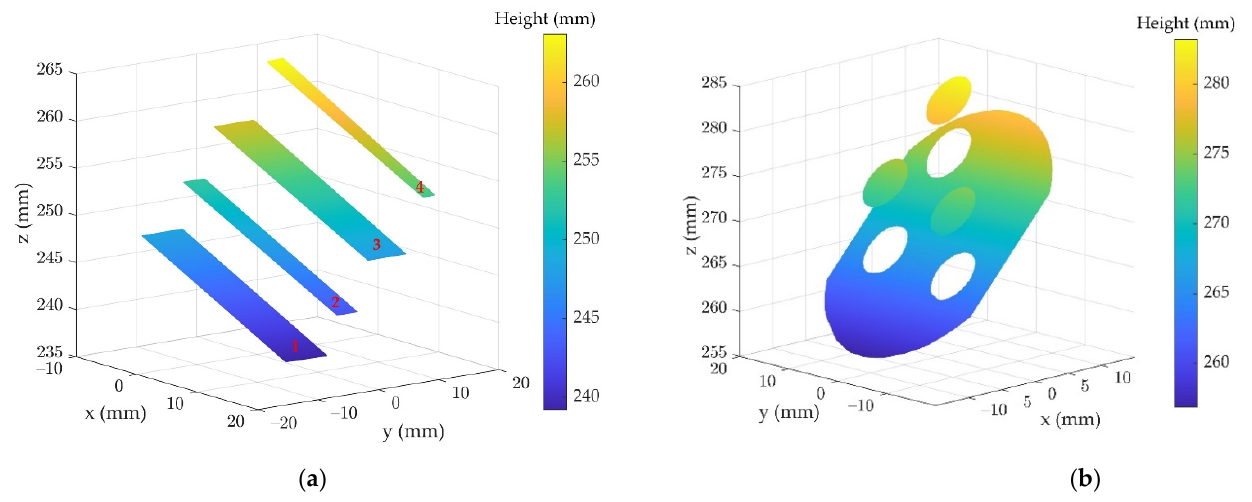
Figure 11. The 3D shape of two samples: ( a ) rectangular step; ( b ) circular step gauge.